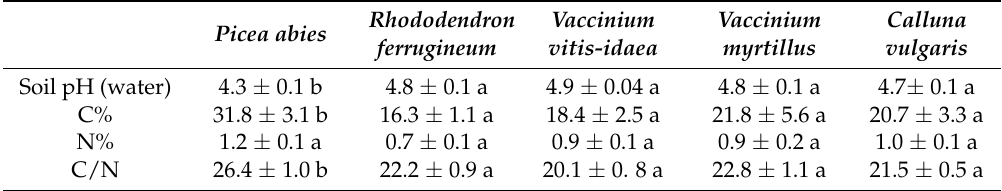
Table 1. Chemical properties of soils taken from under Rhododendron ferrugineum , Vaccinium vitis-idaea , Vaccinium myrtillus , and Calluna vulgaris at the tree line (1668 to 1791 m) and from a neighboring Picea abies diffuse tree line at Wasserberg in the central Alps, Austria. Mean ± SE. Data points within a row not followed by the same letter are significantly different ( p ≤ 0.05) between